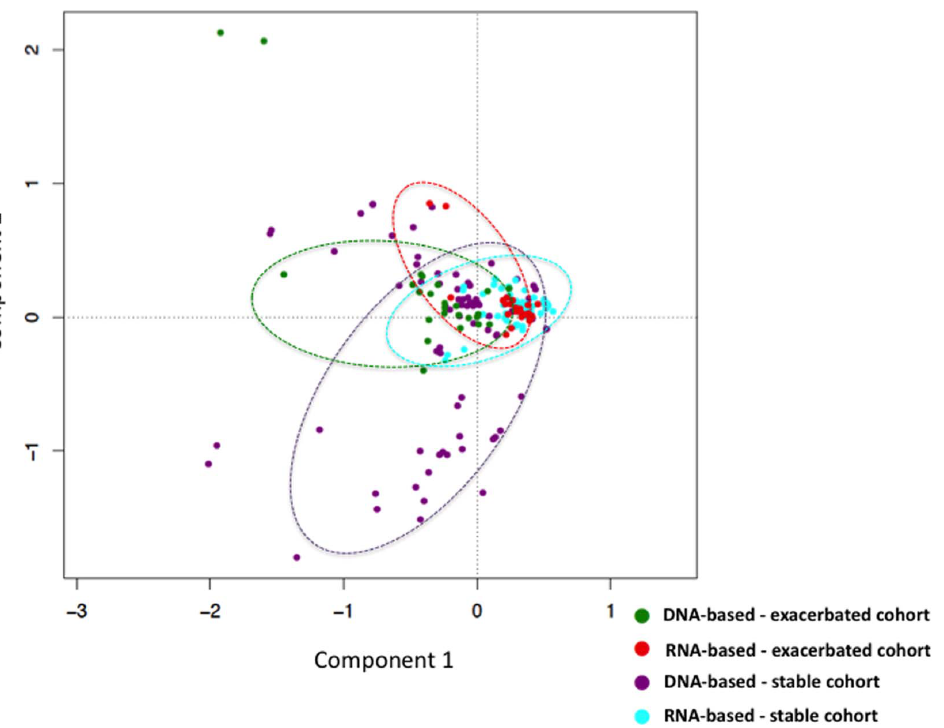
Figure 4. Bacterial community structures of samples from stable CF patients and those presenting with exacerbation as plotted based on Bray–Curtis (BC) distance metric. Each community from each sample is represented as a filled circle and coloured by class (green – total DNA extracted from CF patients presenting with exacerbation; red – total RNA extracted from CF patients presenting with exacerbation; magenta – total DNA extracted from stable CF patients; cyan – total RNA extracted from stable CF patients). BC sample clusters are based on the distribution of the bacterial orders found in an individual sample. A confirmation of differences between samples was validated using the ade4 permutation test. This determined the statistical significance of the BC; the ellipses represent the 95% confidence region.